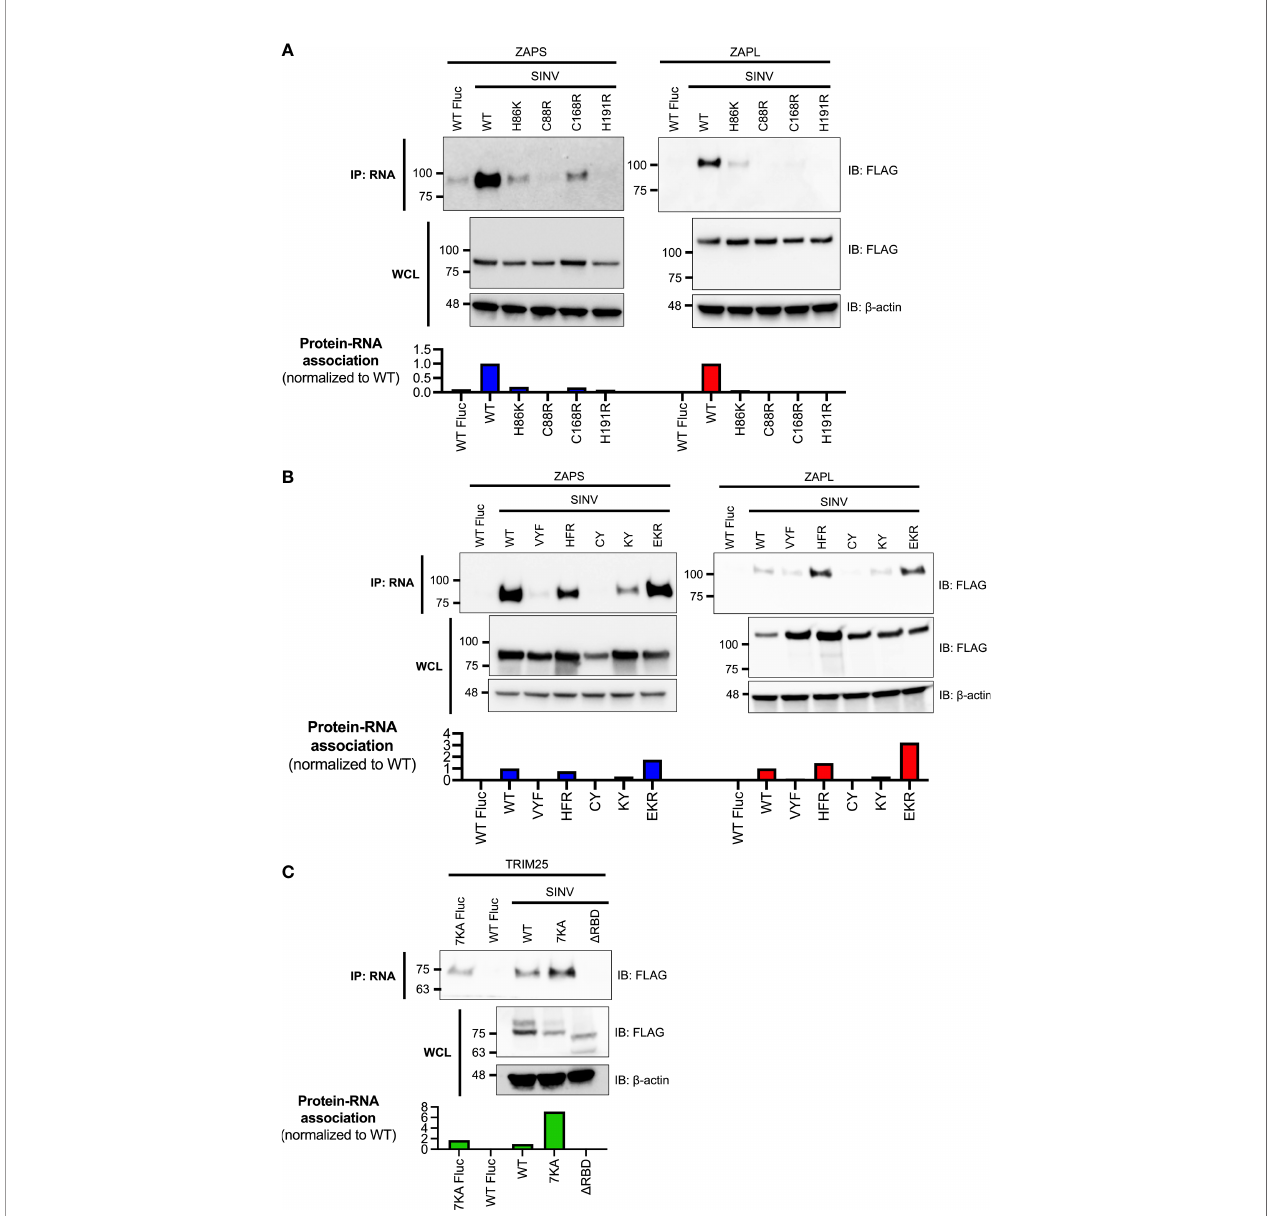
FIGURE 1 | Association of ZAP and TRIM25 RNA binding mutants with SINV RNA. (A, B) ZAP KO or (C) TRIM25 KO 293T cells were transfected with (A) ZAP zinc fi nger (ZnF) mutants, (B) ZAP CpG RNA binding cavity mutants, or (C) TRIM25 mutants. ZAP or TRIM25 pulled down (IP) with Sindbis virus (SINV) or fi re fl y luciferase (Fluc) RNA and in whole cell lysate (WCL) were assayed by immunoblot (IB). Blots were quanti fi ed with ImageJ. Data are representative of two independent